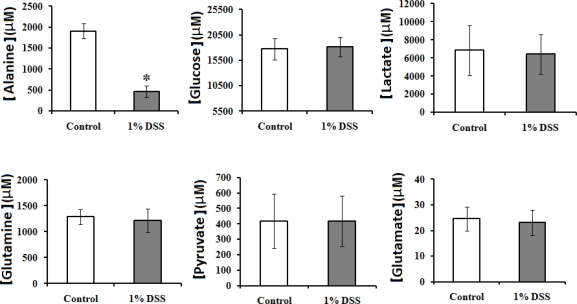
Comparison of the concentration of metabolites in control (□), and 1% DSS-treated (
) Caco-2 cell culture supernatants. All metabolites in cell culture supernatants were collected for each of control and DSS-treated cells at 10, 24, 32, and 56 hours, and metabolites were measured, and averaged. Results therefore represent the mean of 16 determinations ± SD, and * p < 0.00001.